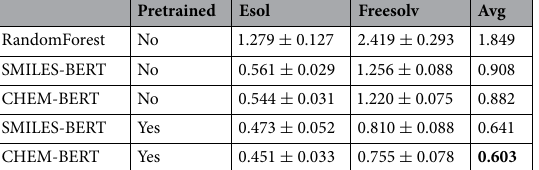
Table 3. RMSE on regression tasks. The best score of each dataset is marked as